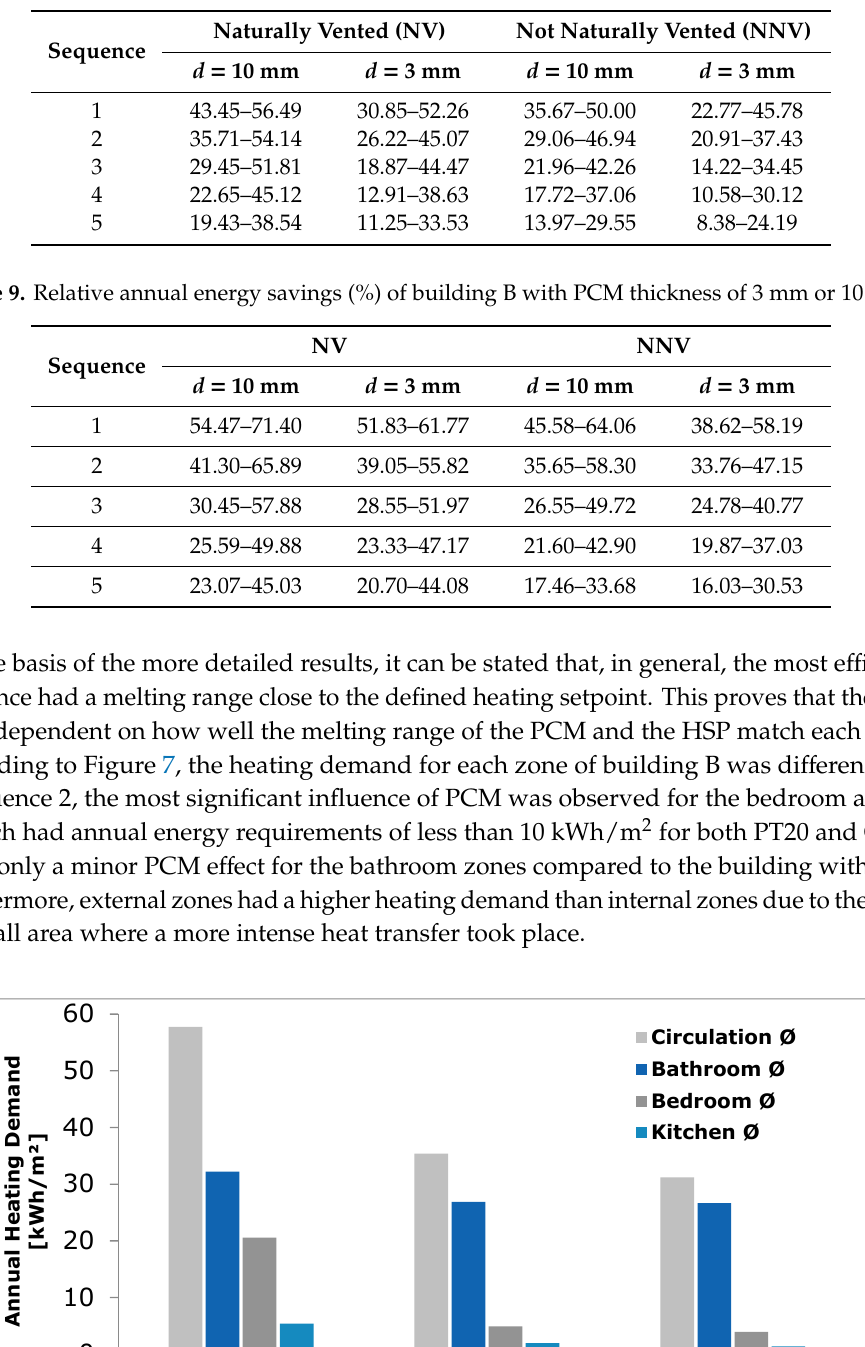
Table 8. Relative annual energy savings (%) for building A with PCM thickness of 3 mm or 10 mm. Sequence